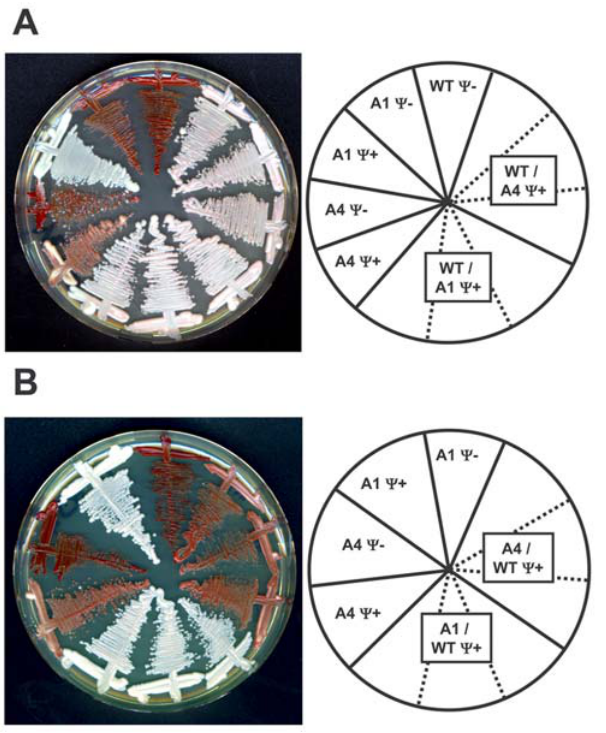
Figure 6. Strains expressing individual Ssaps do not generate different prion strains. (A) The wild-type 74D-694 [ psi 2 ][ pin 2 ] strain was transformed with crude extracts from the A1 [ PSI + ] and A4 [ PSI + ] strains as described in Materials and Methods. Induced 74D-694 [ PSI + ] colonies were isolated and their prion phenotype assessed on 1/2 YPD plates along with the [ psi 2 ] and [ PSI + ] derivatives of the A1 and A4 strains. For each transformation, three independent [ PSI + ] transformants are shown (their positions are indicated by dashed lines on the right panel) (B) The A1 [ psi 2 ] and A4 [ psi 2 ] strains were transformed with a crude cell extract from the 74D-694 [ PSI + ][ pin 2 ] strain. The prion phenotypes of representative [ PSI + ] transformants were assessed on 1/2 YPD plates and compared to those of the original A1 and A4 strains. For each transformation, three independent [ PSI + ] transformants are shown (their positions are indicated by dashed lines on the right panel). In each case, the plates were incubated for 3 days at 28 u C and 4 days at 23 u C.